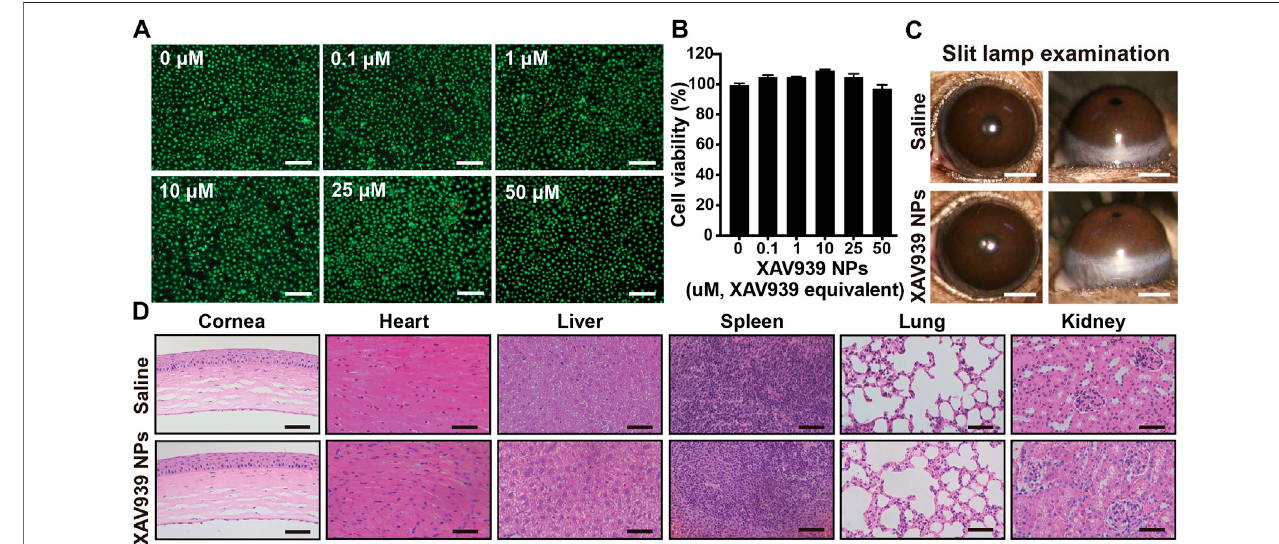
FIGURE2| Invitro and invivo biocompatibilityassessments.Calcein-AM/PIassay (A) andCCK-8assay (B) ofHCEsfollowingexposureofdifferentconcentrations ofXAV939NPs.Resultsarepresented asthemean ± SEM. n (cid:2) 5.Scalebar: 200 μ m. (C) Representative images ofslitlamp examination following14 days treatment